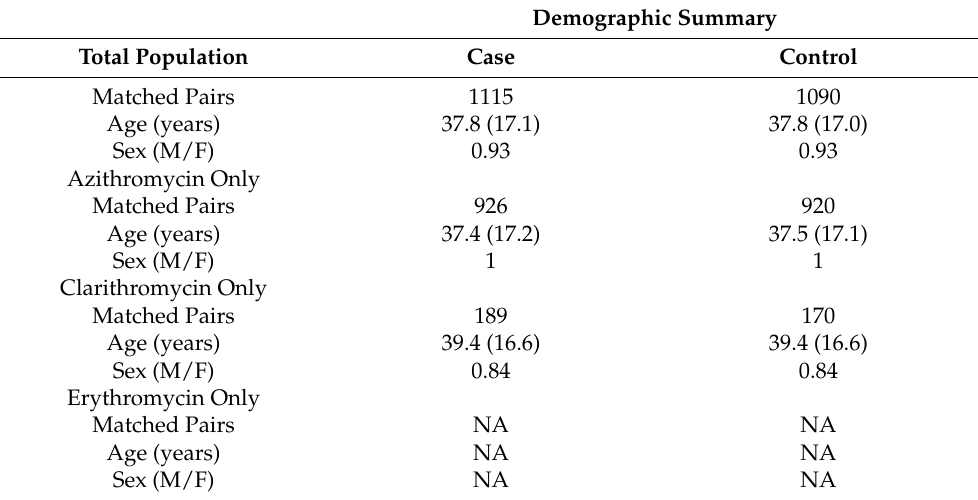
Table 2. Summary of the bacteria-specific CAP study cohort demographic data in total, as well as broken down by macrolide used.